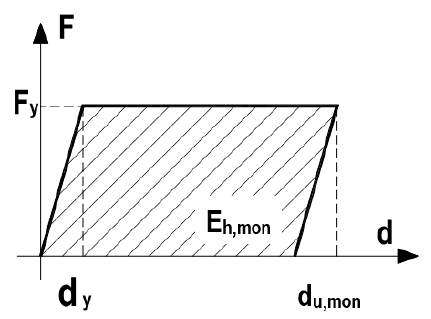
Table 2. Performance evaluation parameters.